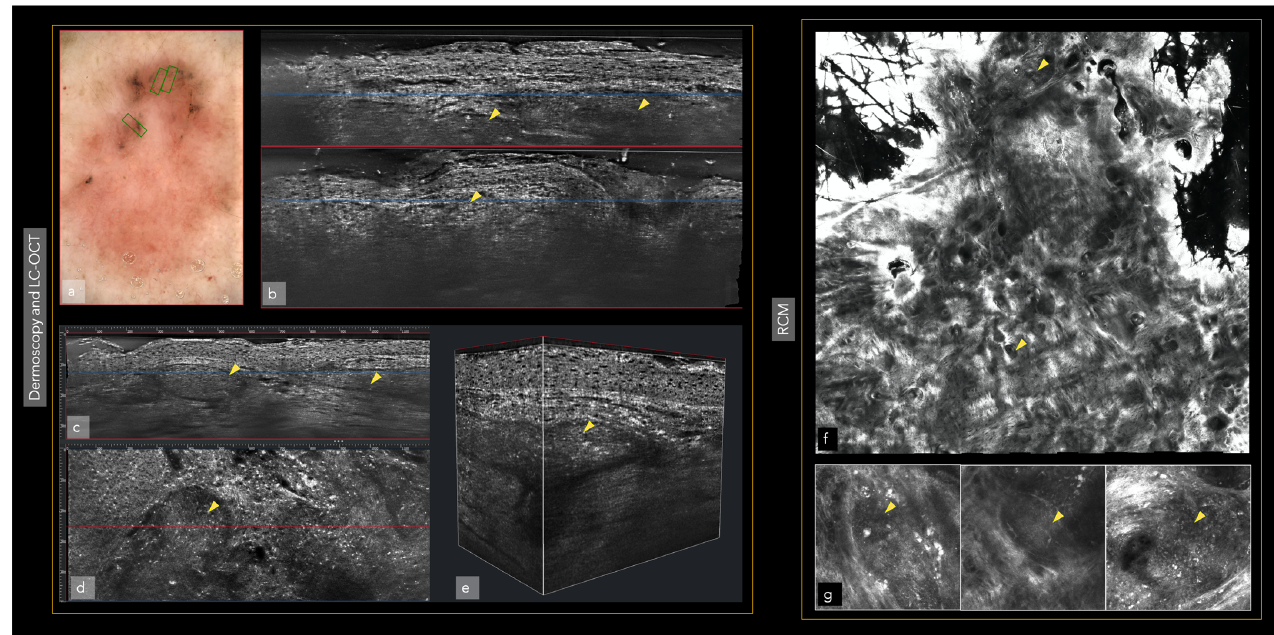
Figure 2. The same superficial and infiltrating basal cell carcinoma in the left arm also studied with LC-OCT and RCM. Tumor presence (yellow triangles). Blue and red lines are the same area represented in the vertical (blue) and horizontal (red) view of LC-OCT: ( a ) Dermoscopy; ( b ) Vertical view of LC-OCT; ( c ) Vertical view of the tumor islands in LC-OCT; ( d ) The same area observed in the horizontal view of LC-OCT; ( e ) 3D view at the same level; ( f ) RCM revealing superficial and infiltrating basal cell carcinoma; ( g ) RCM tumoral details of the superficial component of the basal cell